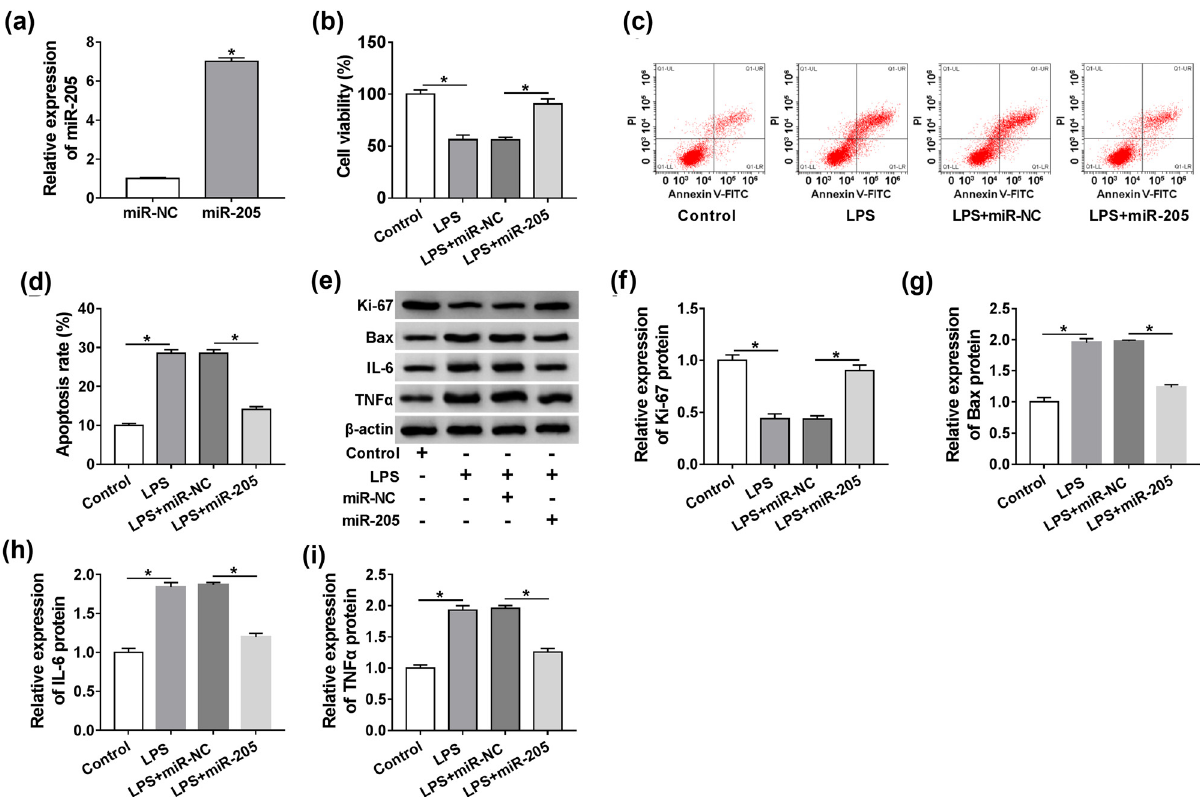
Figure 5: miR - 205 overexpression protected HK - 2 cell from LPS - induced injury. ( a ) qRT - PCR for miR - 205 level in HK - 2 cells transfected with miR - 205 mimic or miR - NC mimic. CCK - 8 assay for cell viability ( b ) , fl ow cytometry for cell apoptosis ( c and d ) , western blot for Ki - 67, Bax, IL - 6, and TNF α levels ( e – i ) in HK - 2 cells transfected with or without miR - 205 mimic or miR - NC mimic before LPS exposure. * P <